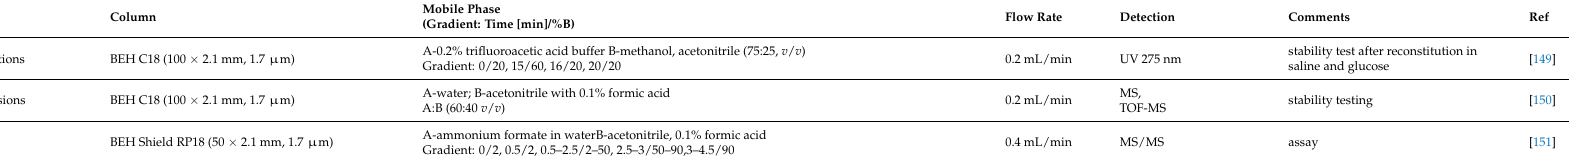
Table 4. UPLC technique in the analysis of other drugs from various therapeutic